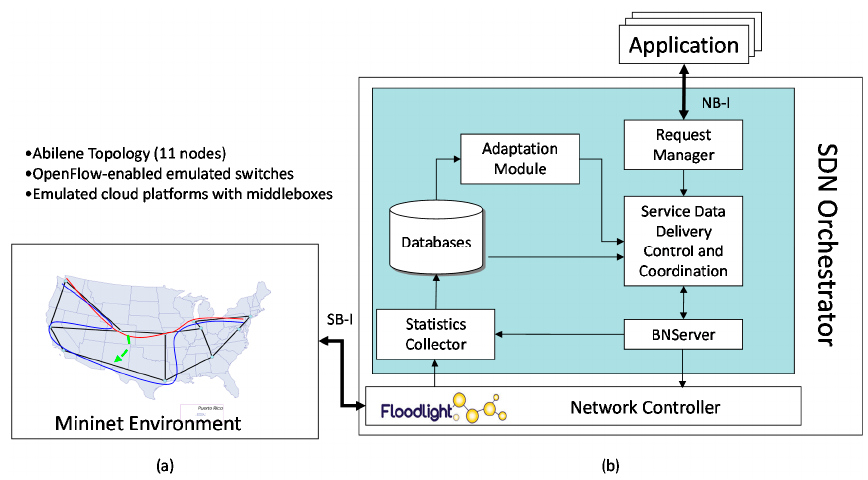
Figure 6. Prototype design and emulated testbed environment. ( a ) Emulation environment adopting the Mininet tool and the Abilene network topology; ( b ) architecture of the SDN Orchestrator